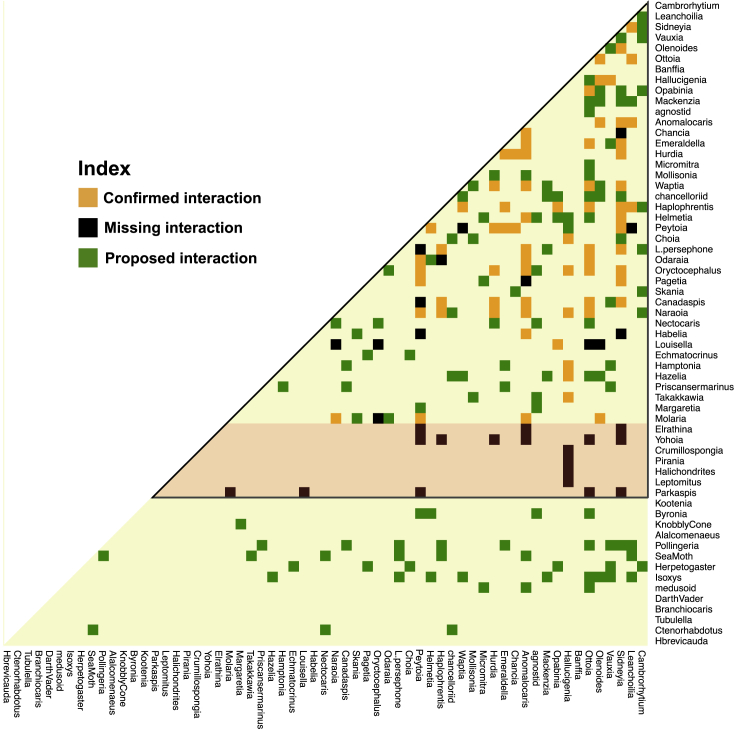
Inferred species interactionsSpecies interaction half-matrix showing consensus interactions from our analysis, as compared with known trophic interactions from literature (Butterfield., 2003; Dunne et al., 2008; Erwin and Valentine, 2012). Confirmed interactions were proposed in the literature and supported in the correlation analyses here. Missing interactions are reported elsewhere but did not obtain any support from our abundance correlation analyses. Proposed interactions are not currently known from the paleontological literature but are suggested by analyses here. The subset of species interactions inside the black triangle were posited in previous studies (Dunne et al., 2008). The species within the light orange area were numerically rare in our data set and no statistically robust prediction could be made regarding their interactions. For classification of confirmed interactions, see Figure S8, and for consistency of interaction, see Figure S9.